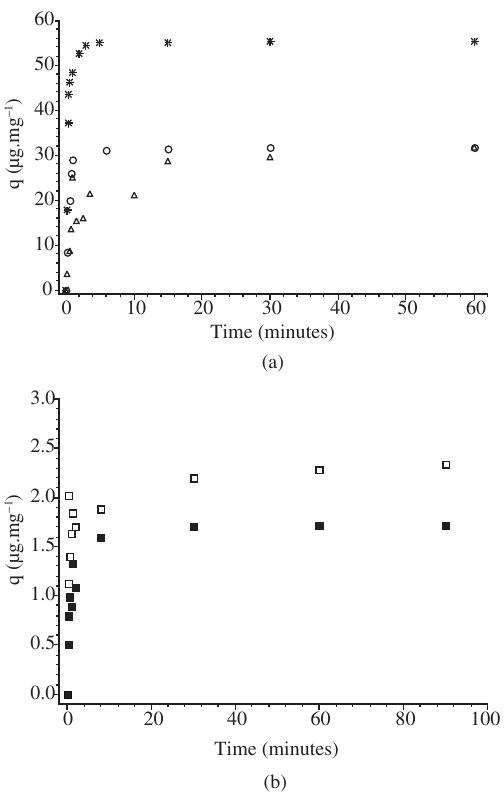
Figure 4. a) Adsorption kinetics of [D-Leucine 1 ]MCYST-LR from PWR